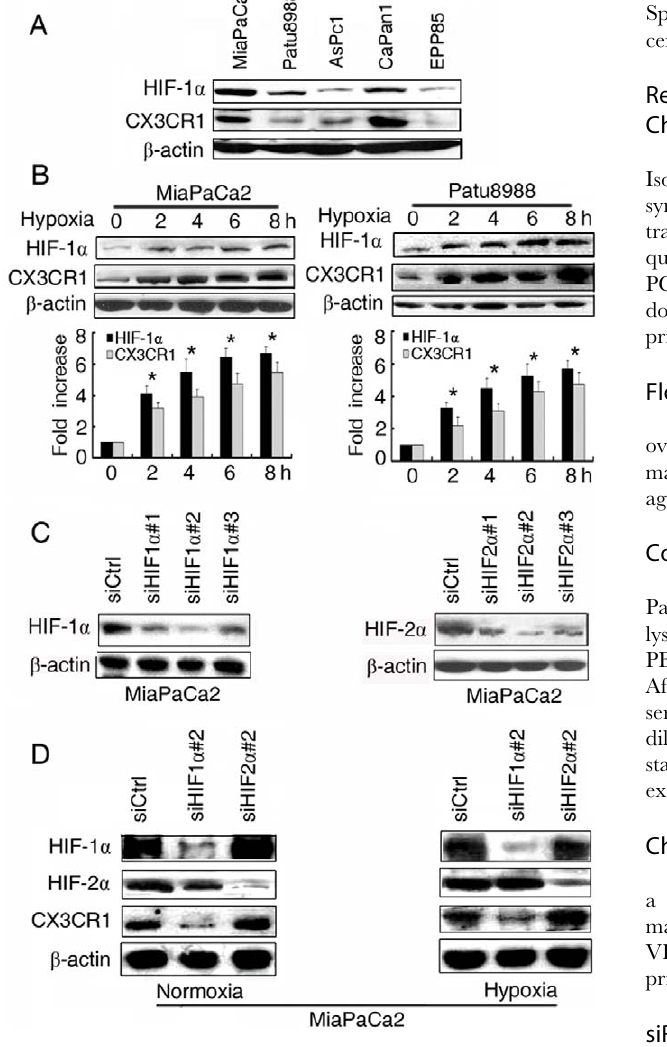
Figure 1. Hypoxia-induced CX3CR1 expression. ( A ) The expres- sion of HIF-1 a and CX3CR1 in five PDAC cells assessed by Western- blotting. ( B ) HIF-1 a and CX3CR1 expression determined by Western- blotting (upper) and qRT-PCR (lower) on MiaPaCa2 (left) and Patu8988 (right) cells cultured under normoxia (21% O 2 ) or hypoxia (1.5% O 2 ) for different times. *P , 0.05 versus control. ( C ) Three specific siRNAs targeting HIF-1 a (left) (50 nM) and HIF-2 a (right) (50 nM) on MiaPaCa2 cells. ( D ) Western-blotting for evaluating the expression of CX3CR1 after knockdown of siHIF1 a # 2 (50 nM) and siHIF2 a # 2 (50 nM) in MiaPaCa2 cells under normoxia and hypoxia